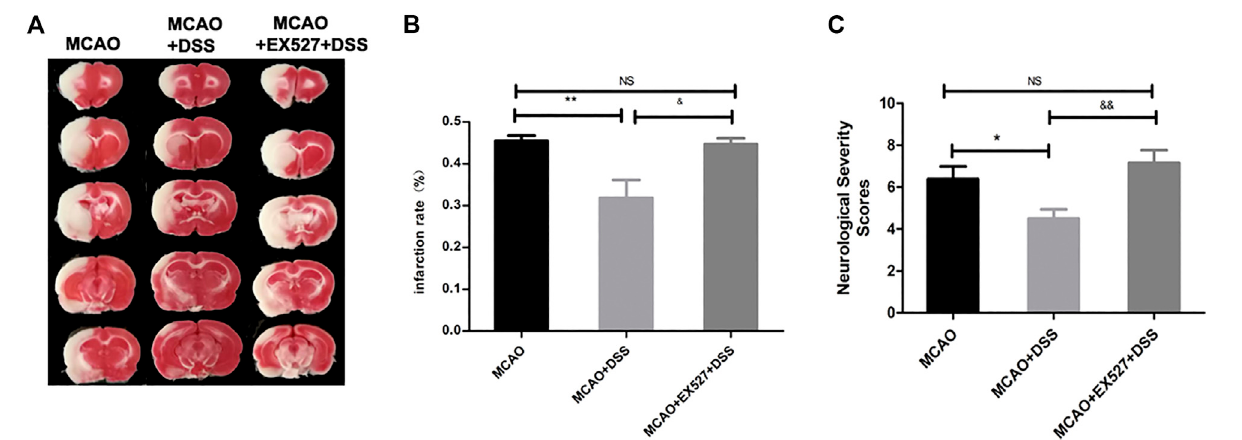
FIGURE6 | SIRT1 inhibitor EX527 ablates the neuroprotectiveeffects ofDSS. Rats weresubjected to2 h of MCAO cerebral ischemia plus 22 h ofreperfusion. (A) Representative TTC staining for infarct sizes. (B) Statistical analysis of infarct sizes as measured by using Image J software. ** p < 0.001, vs. MCAO + DSS group, & p < 0.5,vs.MCAO+EX527+DSSgroup. (C) Statisticalanalysisofneurologicalde fi citscores(mNSS),* p < 0.05,vs.MCAO+DSSgroup,&& p < 0.01,vs.MCAO+EX527+ DSS